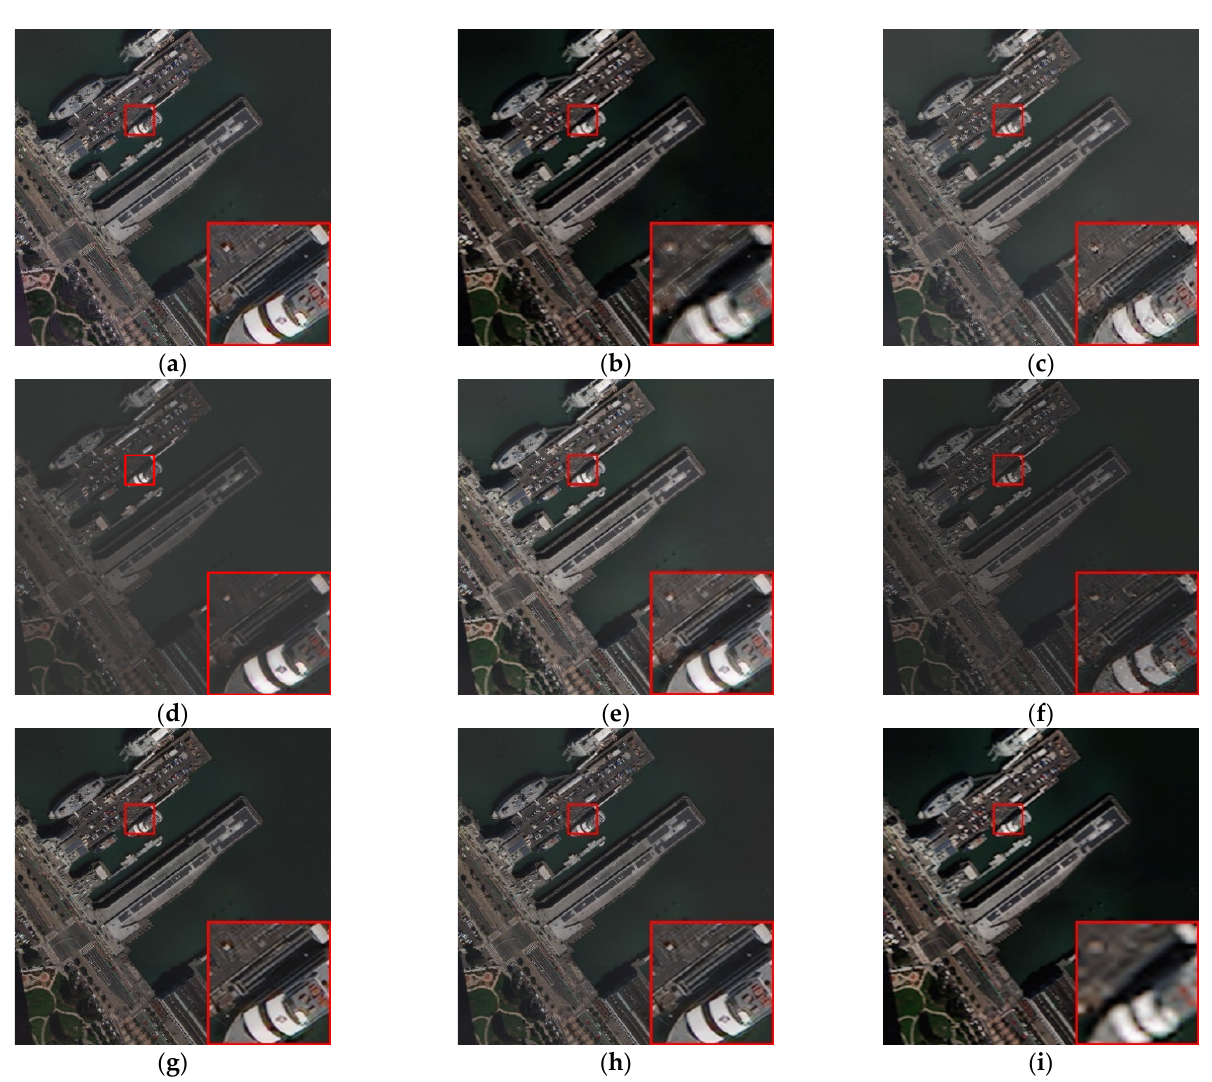
Figure 12. Real experiment results using the GaoFen-2 dataset. ( a ) IHS, ( b ) HPF, ( c ) PRACS, ( d ) Wavelet, ( e ) PNN, ( f ) FusionNet, ( g ) Pansformers, ( h ) LNFIN, ( i ) LRMS.